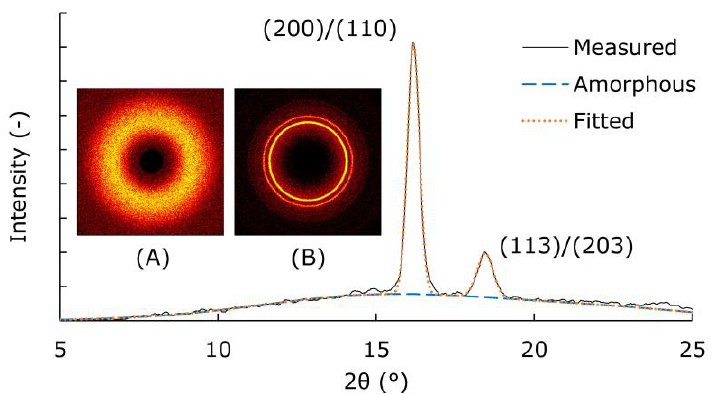
Figure 1. One-dimensional (1D) profile of wide-angle X-ray diffraction of the annealed PLA at 110 °C under reduced pressure. Amorphous halo ( A ); diffraction from (200), (110), (203), and (113) planes ( B ).